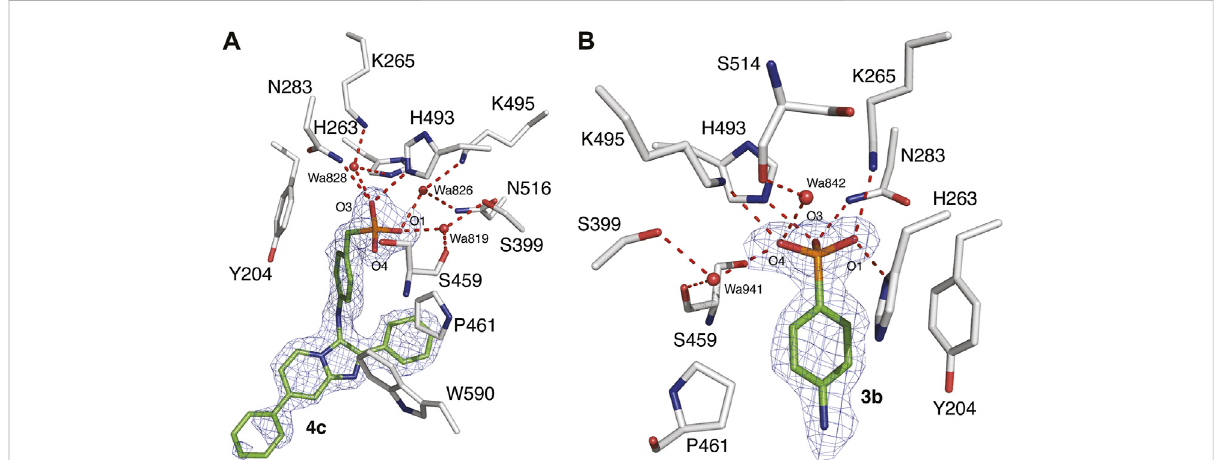
FIGURE 5 X-ray crystal structures of TDP1 bound to compounds 4c and 3b . (A) Structural representation of the TDP1 active site (chain B, carbon atoms in gray) complexed to compound 4c (carbonatoms ingreen, PDB code: 7UFY). Hydrogenbonds are depicted as red dashes. The fi t of 4c to the 2 F o -F c electron density map (blue, 1.58 Å resolution, 0.9 σ level contour) is shown. (B) Structural representation of the TDP1 active site (chain A) complexed to compound 3b (PDB code: 7UFZ). The fi t of 3b to the 2 F o -F c electron density map (blue, 1.56 Å resolution, 1.0 σ level contour) is